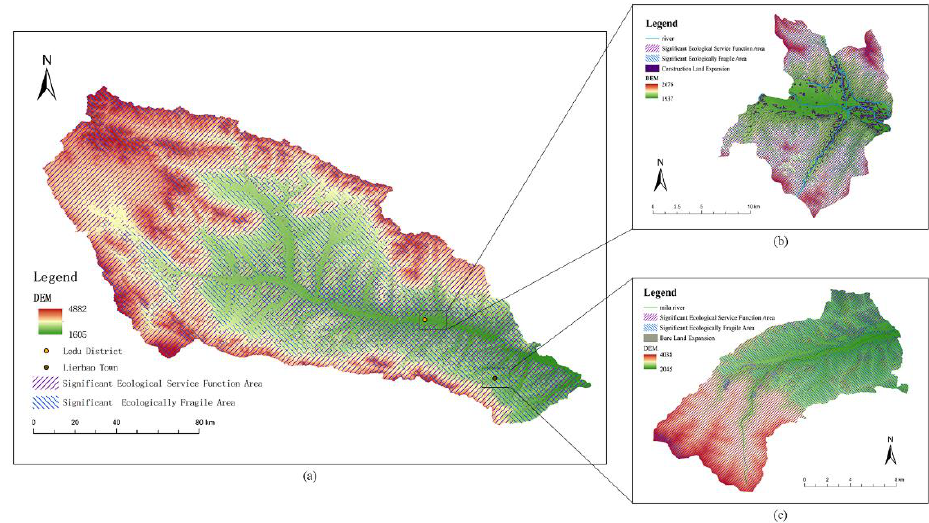
Figure 6. Results of ecological protection importance evaluation and risk analysis: ( a ) Huangshui Basin; ( b ) Ledu District; ( c ) Lierbao town in Minhe County. (WGS84, 1 : 975 000)